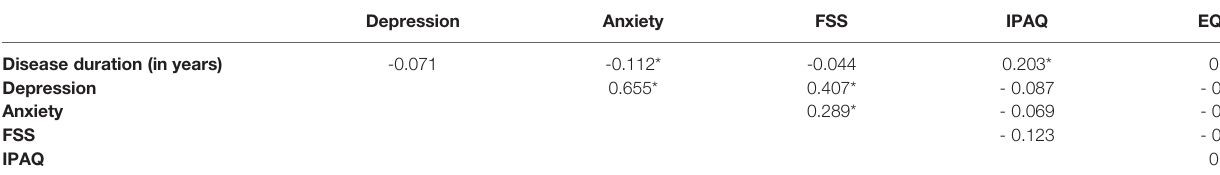
TABLE 6 | Correlations Between Depression, Anxiety, EQ-VAS, FSS, and IPAQ.